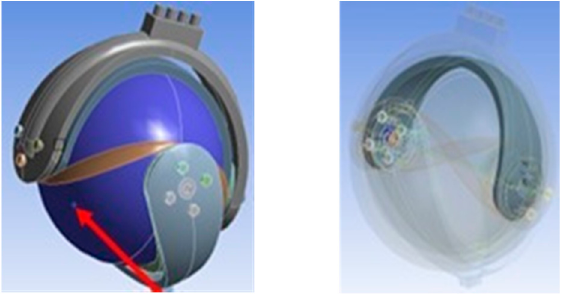
Figure 2. Spherical joint based on smart fluids (magnetorheological fluid).